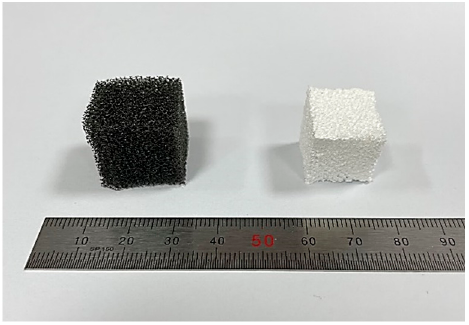
Figure 1. Optical images of polyurethane foam with a pore density of 45 PPI ( left ) and a reticulated porous ZTA specimen ( right ).